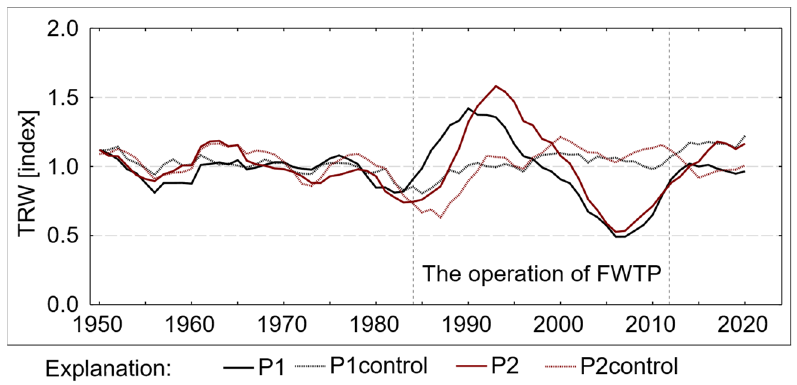
Figure 10. Growth responses of the Scots pines growing at the Forest Wastewater Treatment Plant.